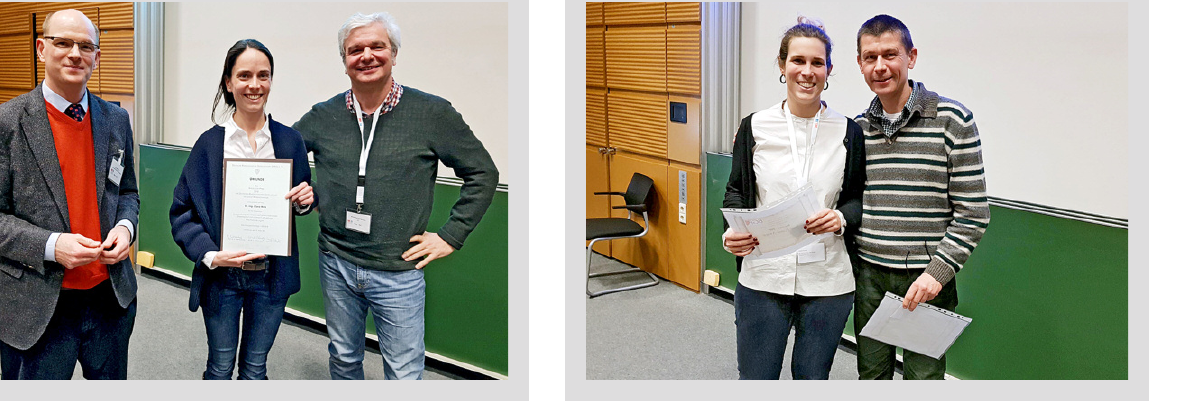
Figure 1: Clara Weis from KIT Karlsruhe receiving the DRG Best Thesis Award award by Ulrich A. Handge (left) and Norbert Willenbacher (right).